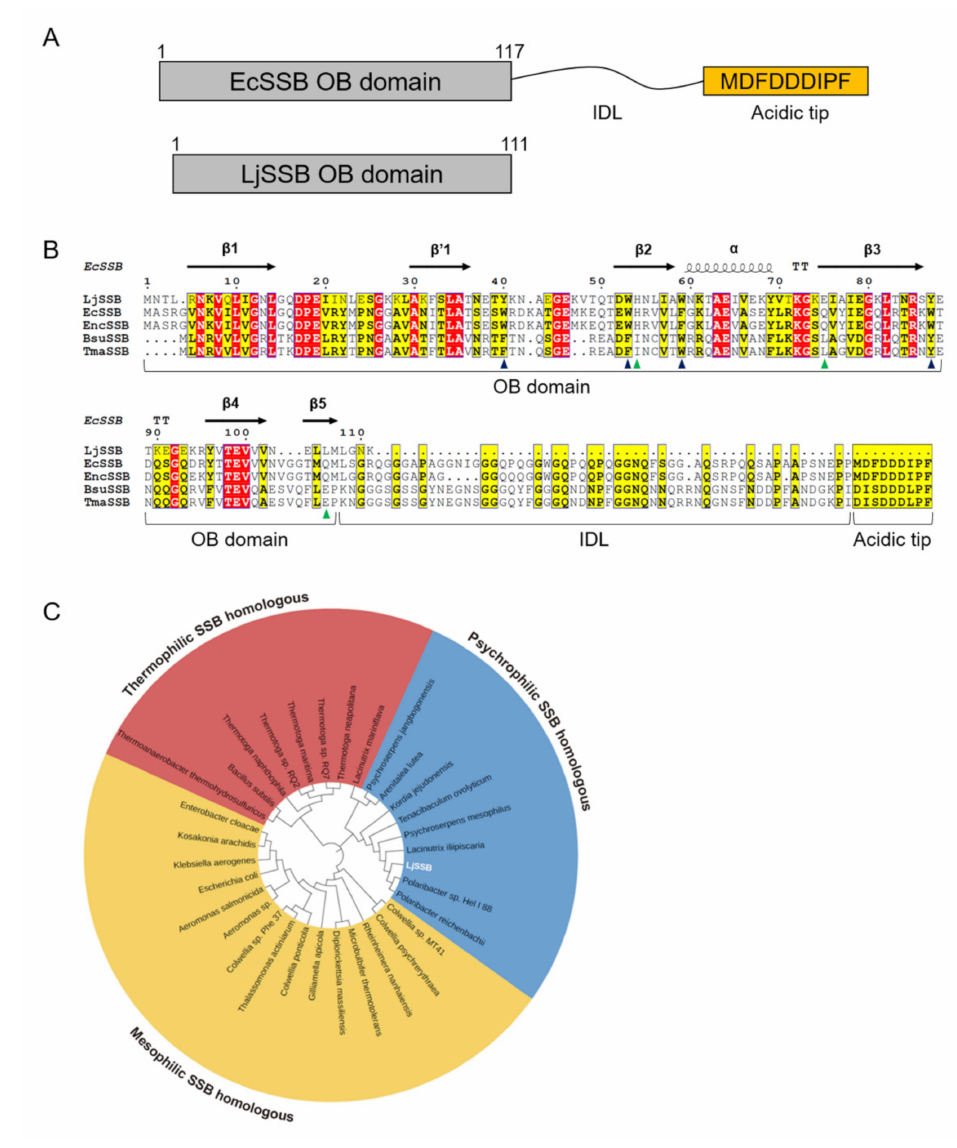
Figure 1. Sequence analysis for LjSSB. ( A ) The comparison of domain architecture of LjSSB and EcSSB. In contrast with EcSSB, LjSSB does not have a C-terminal domain. ( B ) Multiple sequence alignment for SSBs. LjSSB from Lacinutrix jangbogonensis PAMC 27,137 in this study; EcSSB from Escherichia coli (GenBank ID: EEV5779109.1); EncSSB from Enterobacter cloacae (GenBank ID: WP_094085120.1); BsuSSB from Bacillus subtilis (GenBank ID: WP_153257179.1); and TmaSSB from Thermotoga maritima (GenBank ID: WP_004081225.1). The secondary structure deduced from EcSSB (PDB code: 1KAW) is showed on the top of aligned sequences. The strictly conserved regions are highlighted in red, and homologous regions are highlighted in yellow. The ssDNA binding site and oligomerization- involved residues from EcSSB are labeled using blue and green triangles, respectively. ( C ) The amino acid sequences for psychrophilic, mesophilic, and thermophilic SSBs were aligned using ClustalW, followed by construction of neighbor-joining (NJ) phylogenetic trees with 1000 bootstrap replicates using MEGA-X software. The tree display was obtained with online iTOL